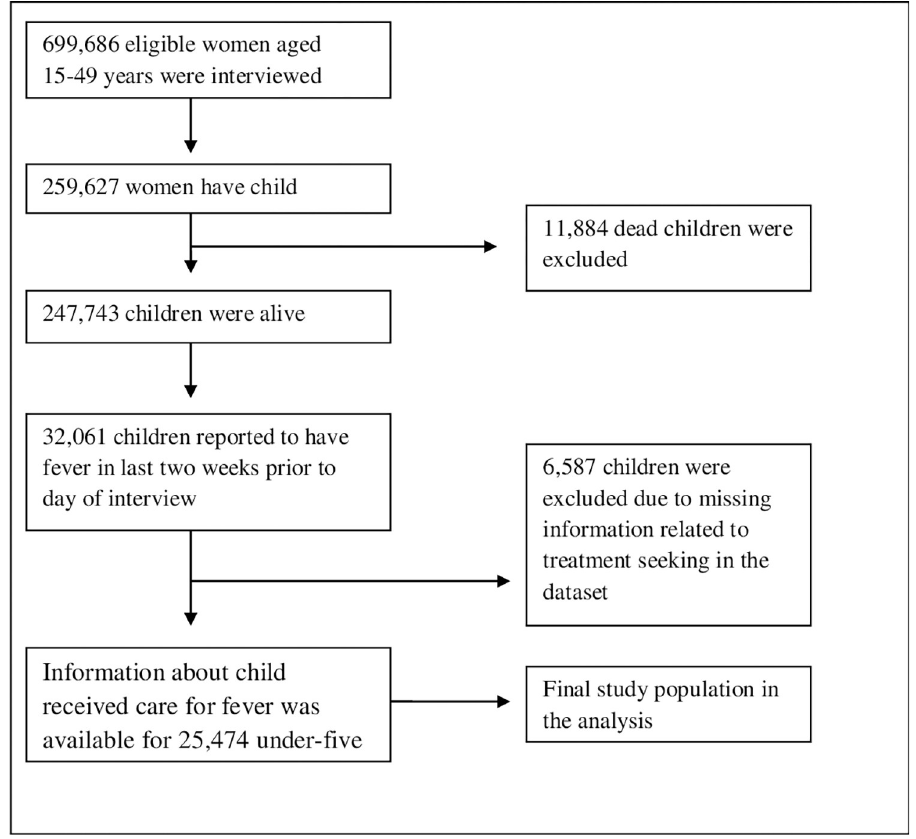
Fig 1. Selection of study participants,